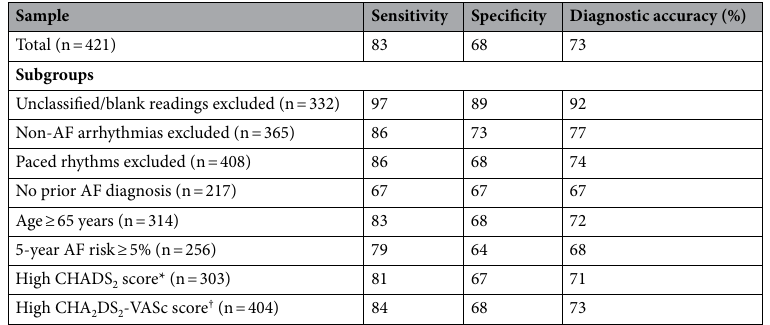
Table 3. Diagnostic performance of the KMCM for detecting AF. AF atrial fibrillation, KMCM Kardia Mobile Cardiac Monitor.